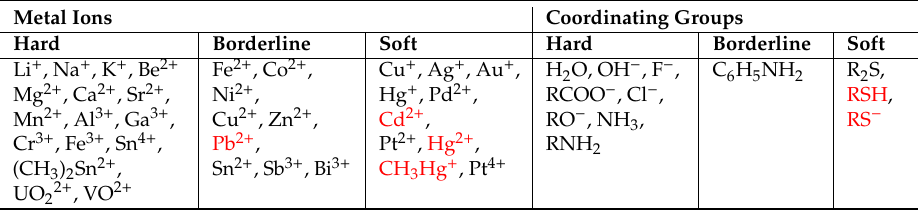
Table 1. Classification of the toxic metals, and the coordinating groups, according to their hard, intermediate (borderline), and soft character. The implied metal ions and coordinating groups are marked in red.